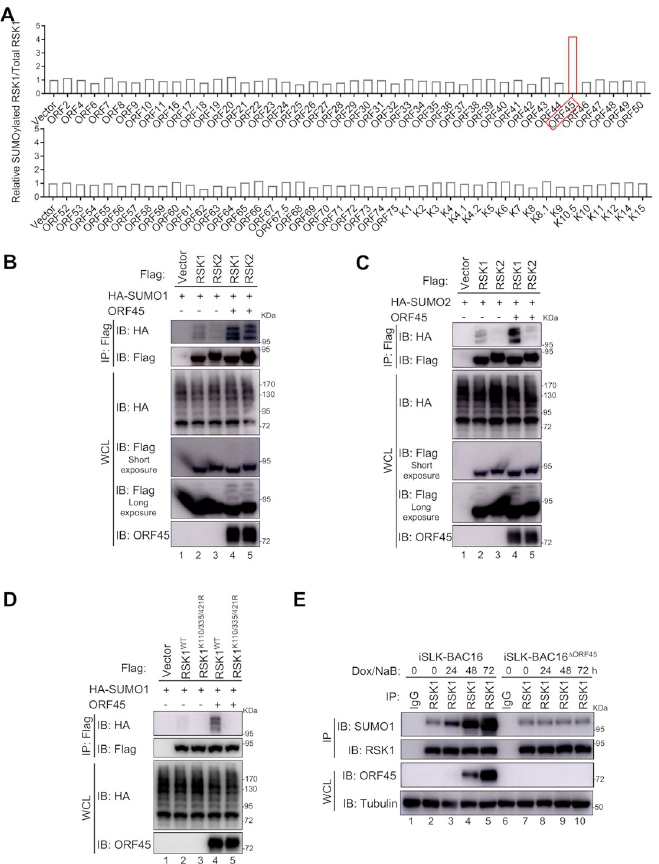
Fig 1. KSHV ORF45 facilitates RSK1 SUMOylation. ( A ) KSHV ORF45 enhances RSK1 SUMOylation. Individual KSHV encoded gene or vector control was co-expressed with HA-RSK1 and denatured immunoprecipitation (IP) and immunoblot (IB) were performed at 48 h post-transfection. The band intensities of SUMOylated RSK1 and total RSK1 were quantified and the ratio was calculated. ( B-C ) ORF45 promotes the SUMOylation of RSK1 and RSK2 by SUMO1/2. HEK293T cells were transfected with indicated plasmids and cell lysates were subjected to denatured IP and IB with indicated antibodies at 48 h post-transfection. ( D ) ORF45 facilitates RSK1 SUMOylation on K110, K335, and K421. ( E ) ORF45 is required for KSHV-mediated RSK1 SUMOylation. iSLK-BAC16 and iSLK-BAC16 Δ ORF45 cells were treated with doxycycline and sodium butyrate to induce KSHV lytic replication. Cells were collected at 0, 24, 48, and 72 h post-treatment and subjected to denatured IP and IB with indicated